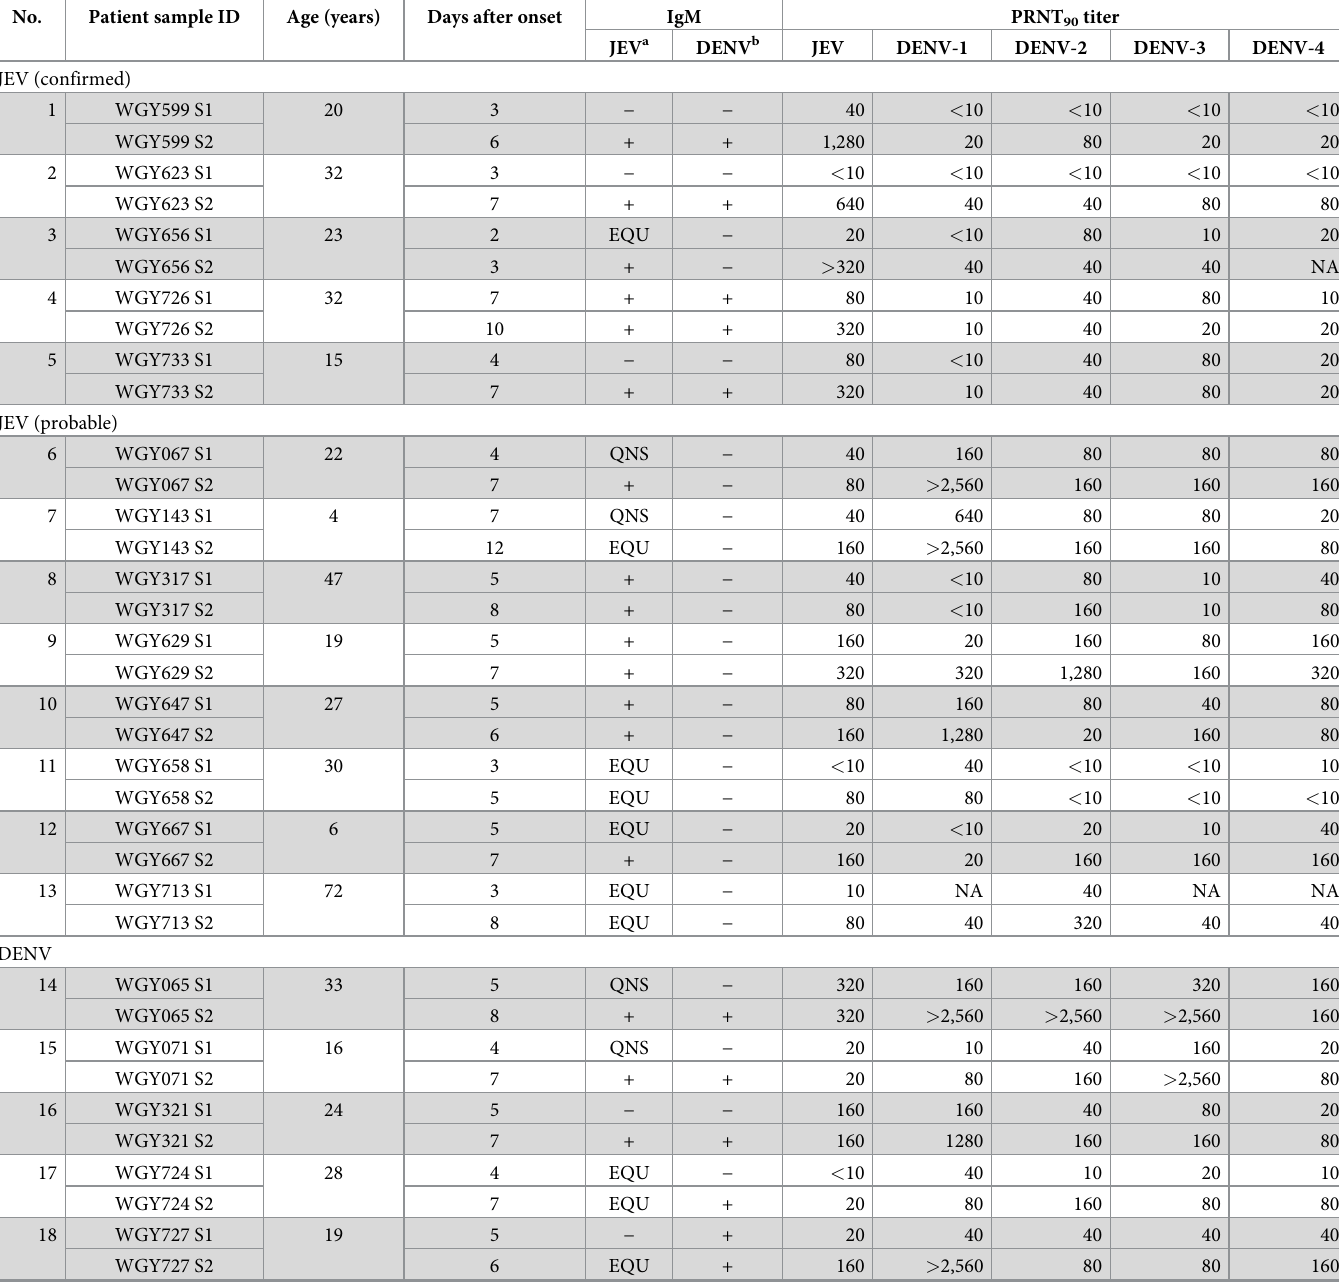
Table 2. Serology testing results from non-encephalitic acute febrile illness patients with confirmed JEV, probable JEV, DENV, and flavivirus infection.